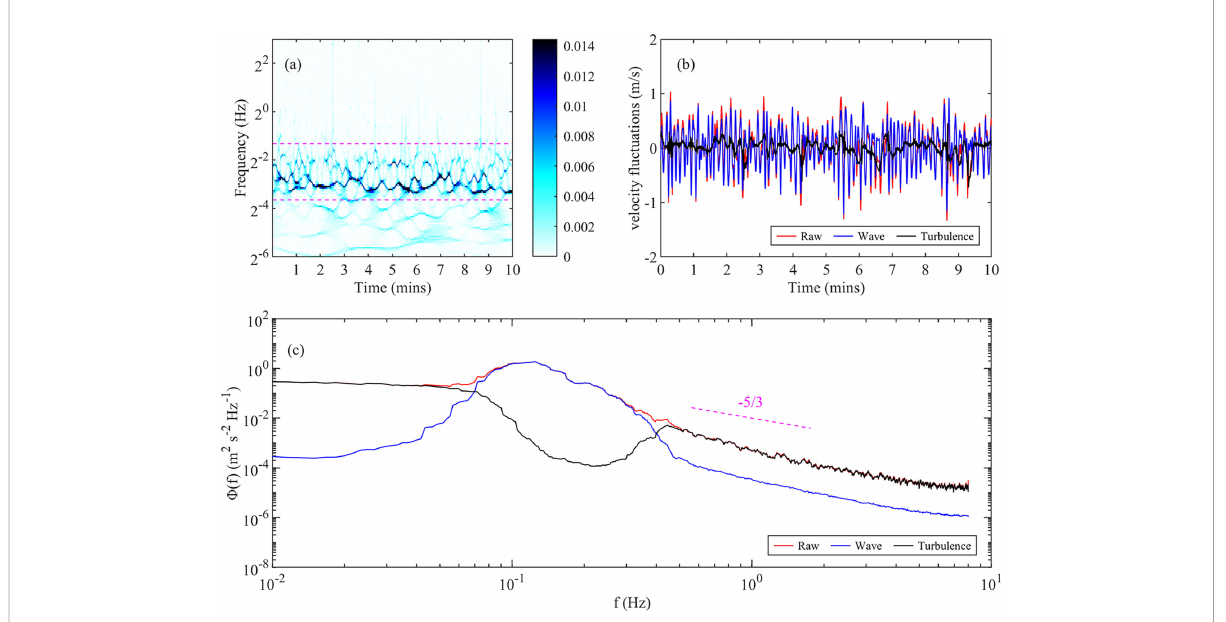
FIGURE 3 Wave – turbulence decomposition results of ADV-measured near bottom water motion (Burst = 28, Hs = 2.4 m). (A) Synchrosqueezed wavelet transform (SWT) of u ′ ; pink dashed lines indicate the wave-dominant frequency. (B) Time series of the original velocity fl uctuation u ′ (red) and each component reconstructed using the SWT method; blue and red lines represent the wave and turbulent components, respectively. (C) Power spectra of the u ′ (red), and the decomposed wave motions (blue) and turbulence (black); pink dashed lines indicate Kolmogorov ’ s “ − 5/3 ” theoretical